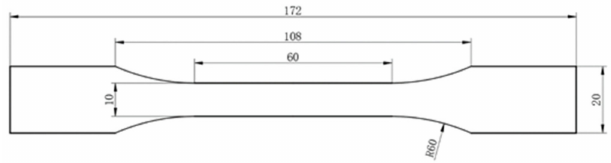
Figure 2. The size of tensile